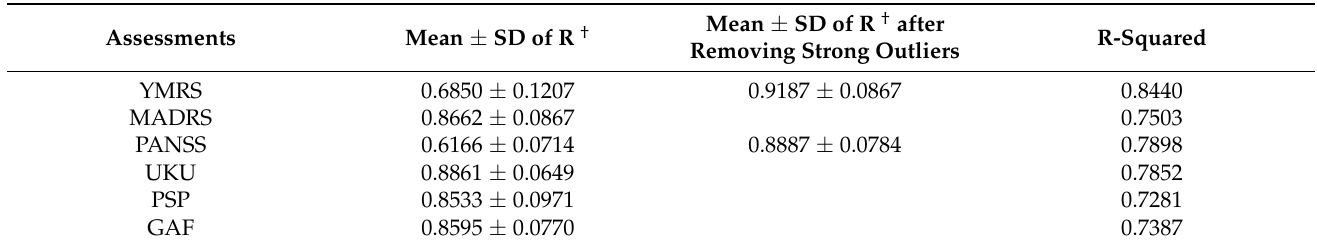
Table 2. Regression performance of the models used for predicting the changes in symptom and functioning scores.